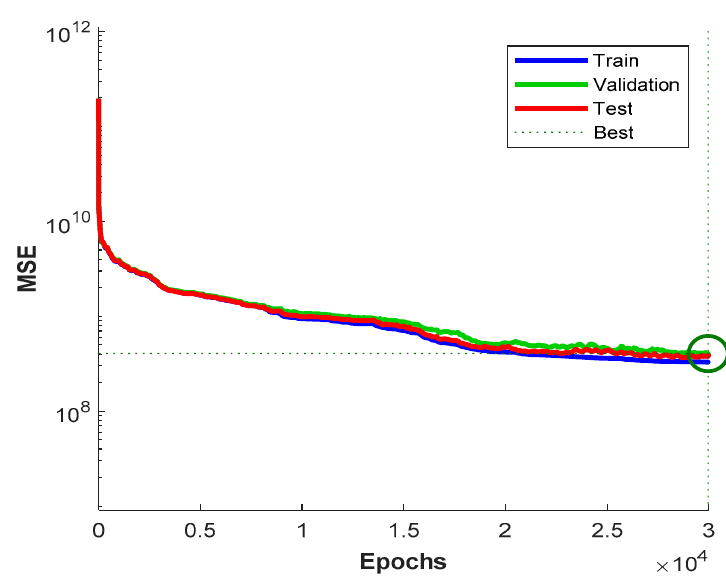
Figure 7. Performance of surrogate model according to epochs.